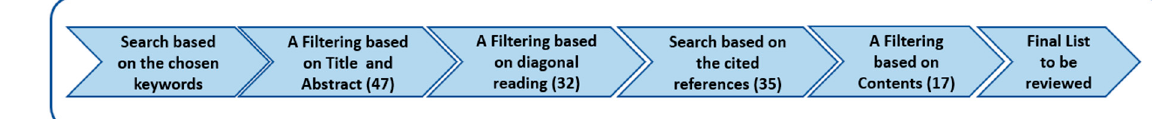
Figure 3. Research Methodology.